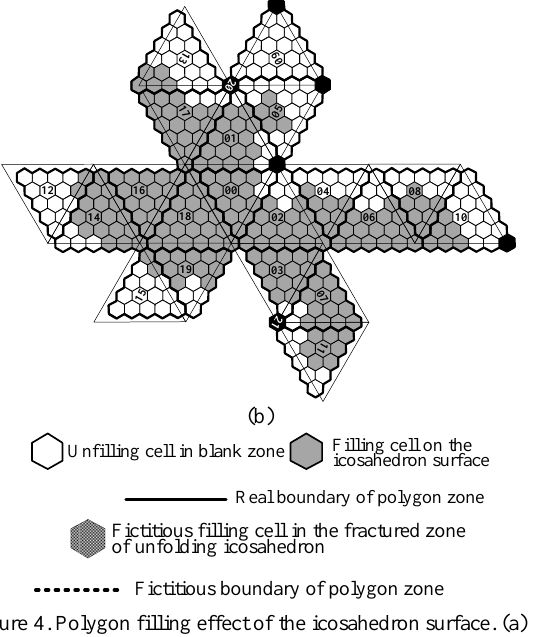
Figure 4. Polygon filling effect of the icosahedron surface. (a) Polygon filing by filling method; (b) Final filling project without fictitious cells.